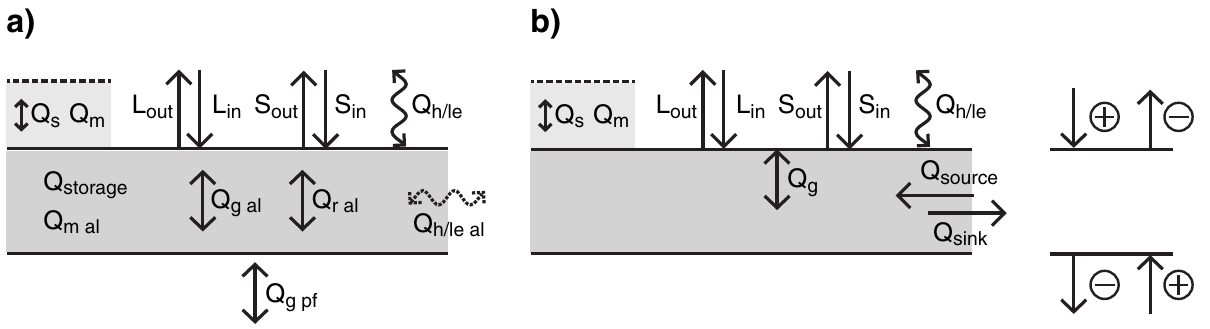
Figure 2. Illustration of the di ff erent energy exchange processes in (a) the energy balance calculations according to Eqs. (1–3) and (b) in the Coup Model. The scheme on the right-hand side shows the convention of positive and negative Fig. 2. Illustration of the different energy exchange processes in (a) the energy balance calcu- lations according to Equations (1) – (3) and (b) in the Coup Model. The scheme on the right hand side shows the convention of positive and negative fluxes.